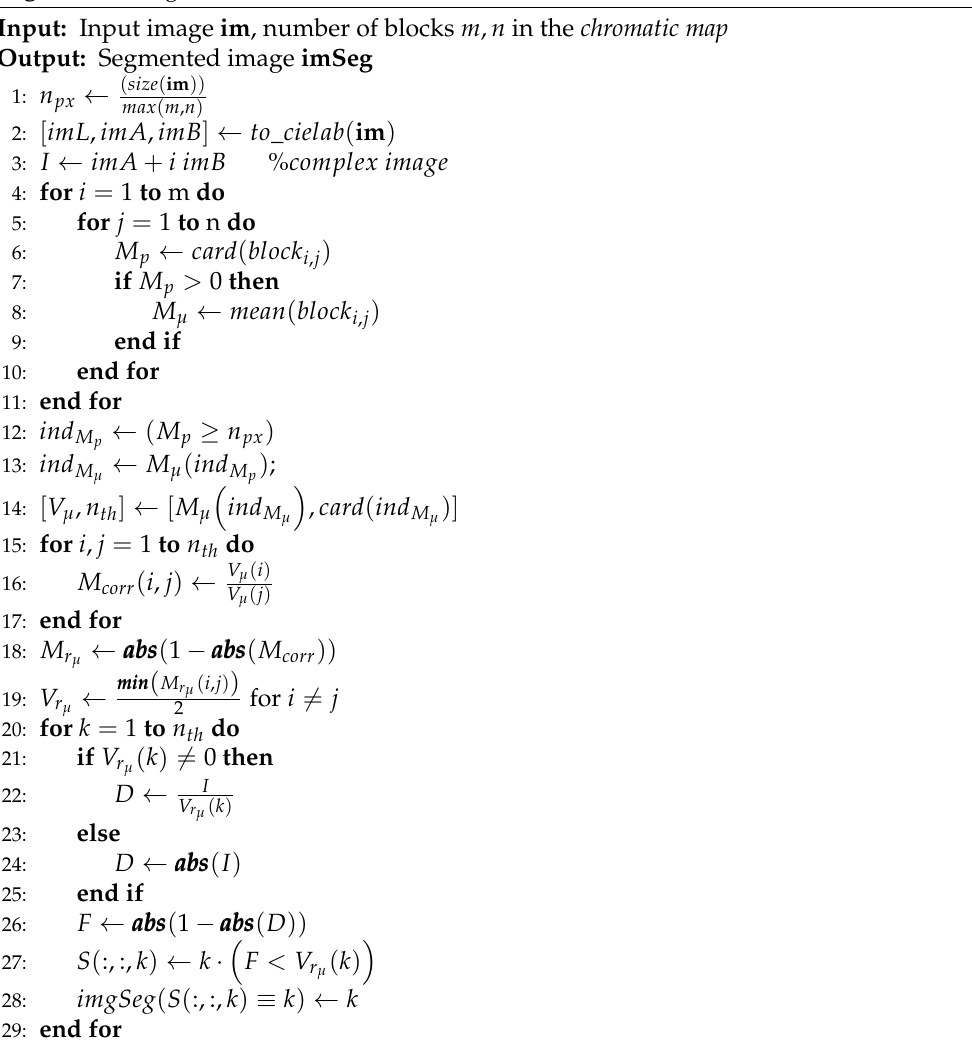
Algorithm 1 Segmentation